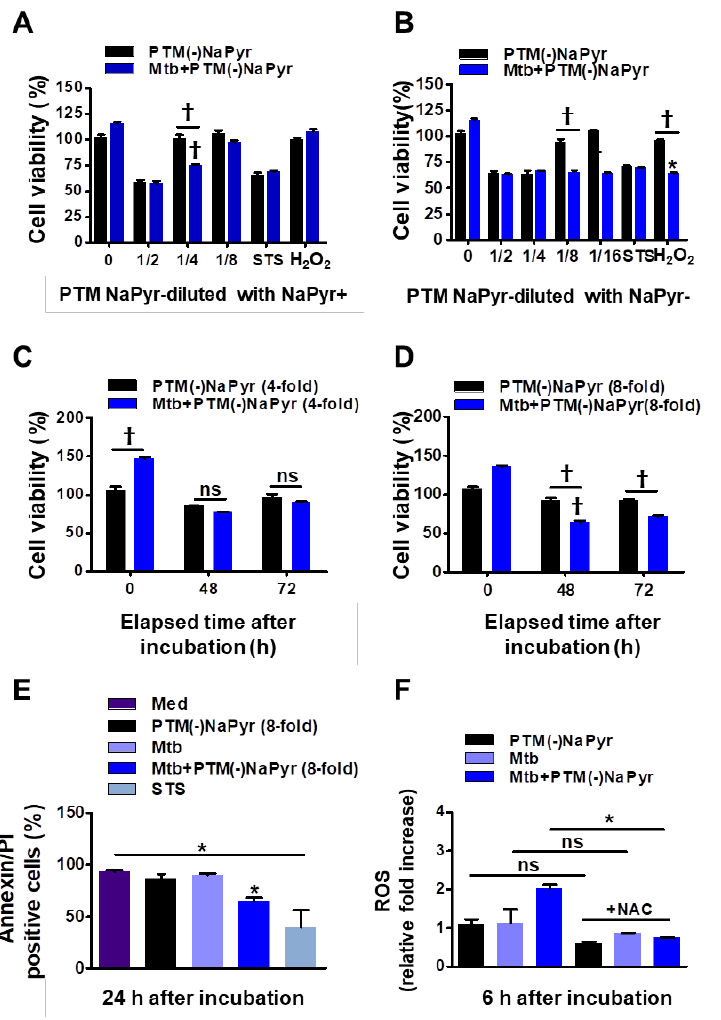
Figure 4. Comparison of effects of PTM without NaPyr diluted in medium with or without NaPyr. Uninfected or Mtb -infected BMDMs (2 × 10 4 /well of 96-well plates) (MOI 1) were incubated for 24 h in various dilutions of PTM without NaPyr in culture media with ( A ) and without ( B ) NaPyr, then cell viability was determined using CCK-8 assays. Effects of 250 µM H 2 O 2 and 50 nM STS cell viability were also analyzed. Cells were incubated for 48 h and 72 h with ( C ) 4-fold-diluted PTM in medium with NaPyr and ( D ) 8-fold-diluted PTM in medium without NaPyr. ( E ) Death of Raw264.7 cells incubated in PTM without NaPyr evaluated using flow cytometry and annexin/PI staining. ( F ) Intracellular ROS in Raw264.7 cells incubated for 6 h in 8-fold-diluted PTM without NaPyr or PTM treated with NAC (10 mM) without NaPyr, and uninfected, infected control, and Mtb -infected cells incubated in PTM without NaPyr. ( A – F ) * p < 0.05 and † p < 0.001 vs. untreated cells; one- or two-way ANOVA. ns: not significant. Data are shown as means ± SEM of three independent